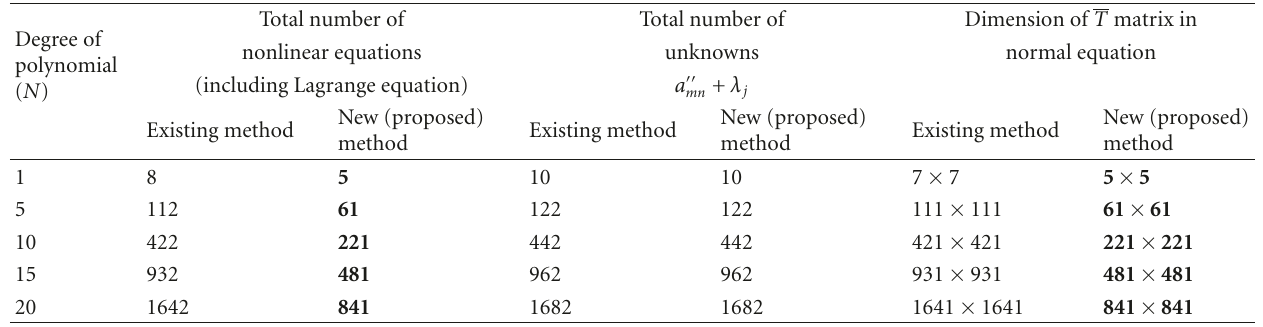
Table 1: Computational